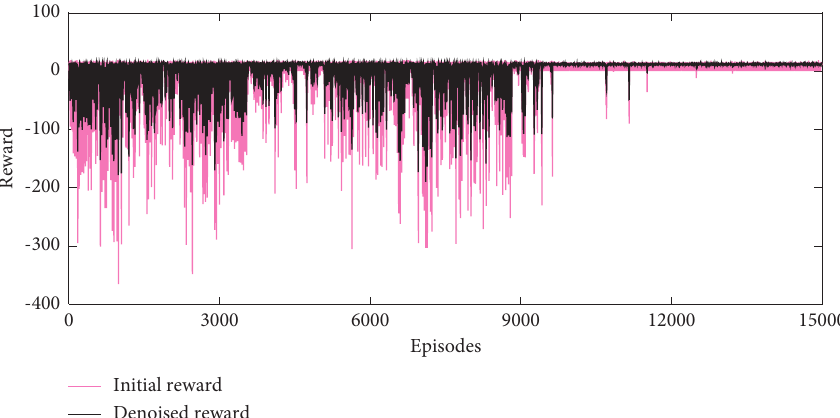
Figure 7: Multiagent reward value update process.